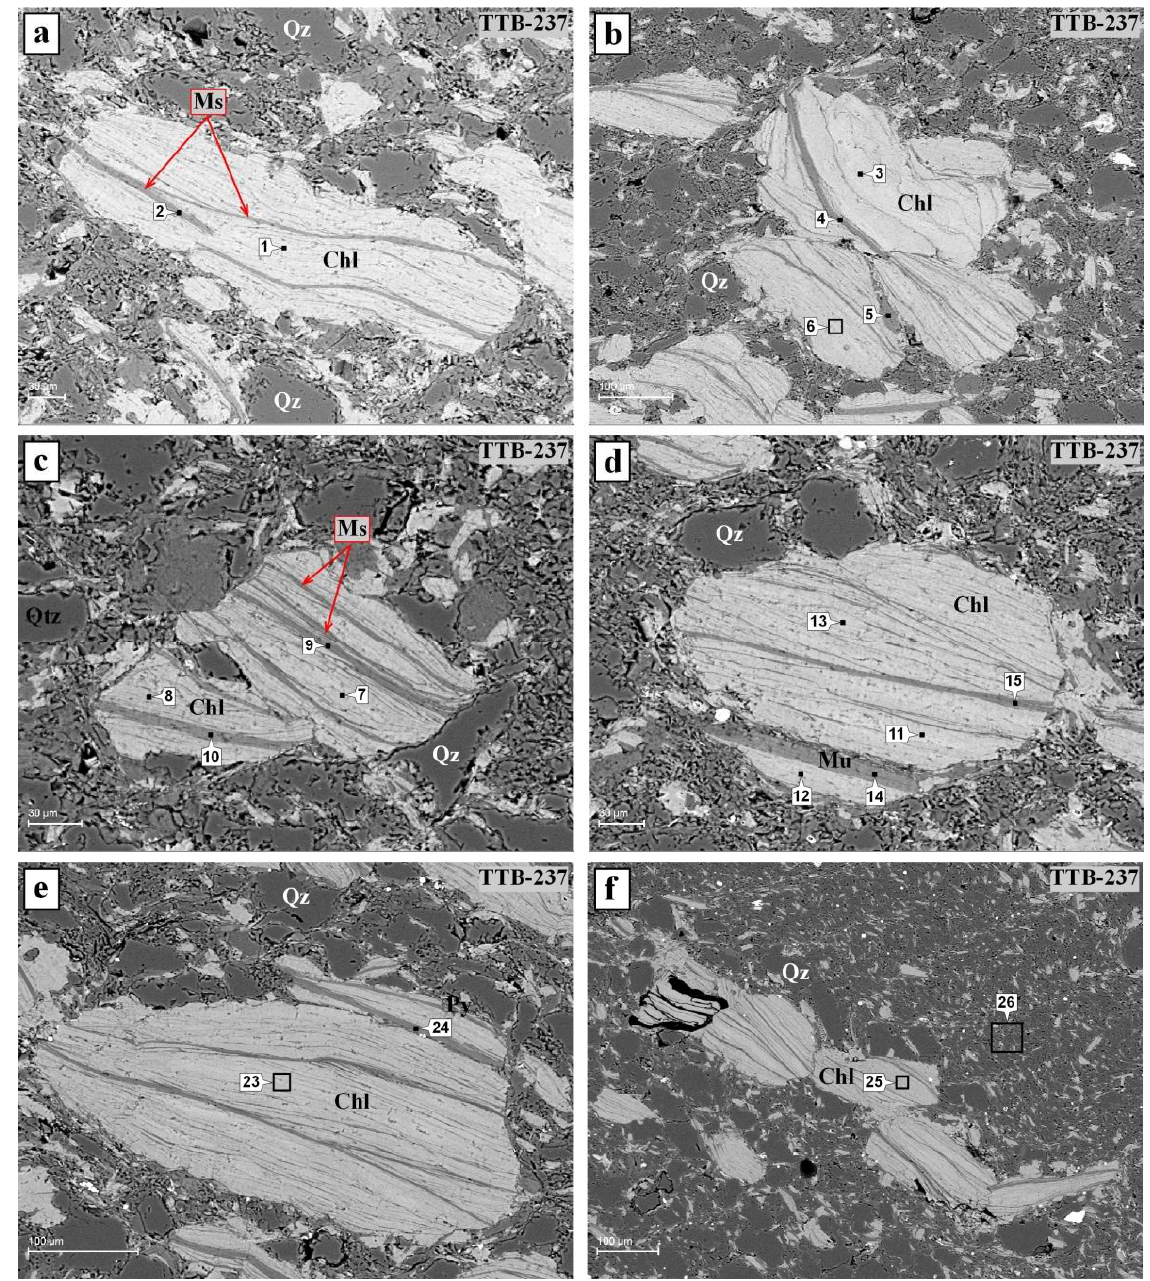
Figure 6. SEM-BSE photomicrographs of the early–middle Ordovician metasandstone with locations of some analyzed points and areas (black rectangulars). ( a ) Elongated chlorite-rich CMS which their stacking planes are nearly parallel to bedding planes and partly disturbed due to cutting by slightly developed cleavage planes, ( b – e ) Lozenge-shaped chlorite-rich CMS cutting by cleavage planes, ( f ) Elongated chlorite-rich CMS which multiple sliced by slightly developed cleavage planes within the groundmass composed of quartz-fine grained-white K-mica and chlorite.